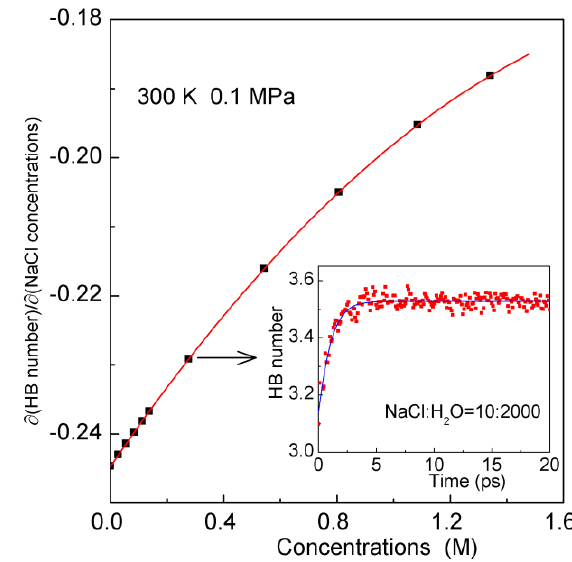
Figure 3. The effects of NaCl salts on hydrogen bonding in water. The fitted line is shown in solid. The inlet shows the changes of hydrogen bonding of NaCl solutions (NaCl:H 2 O = 10:2000) as the system approaching the equilibrium.